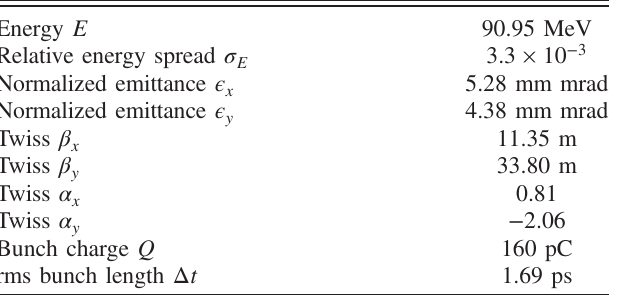
TABLE I. Electron beam parameters for the simulation. The Twiss parameters are given at the linac exit.